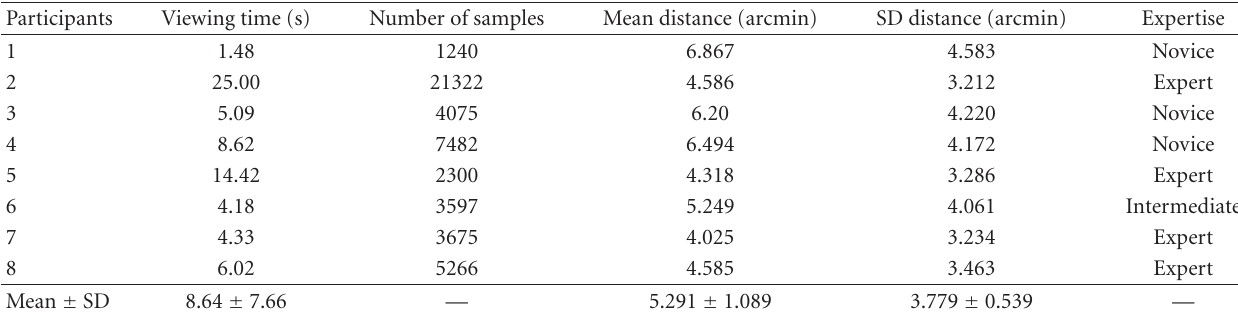
Table 1: Results of Experiment 1 for each participant and for the group.